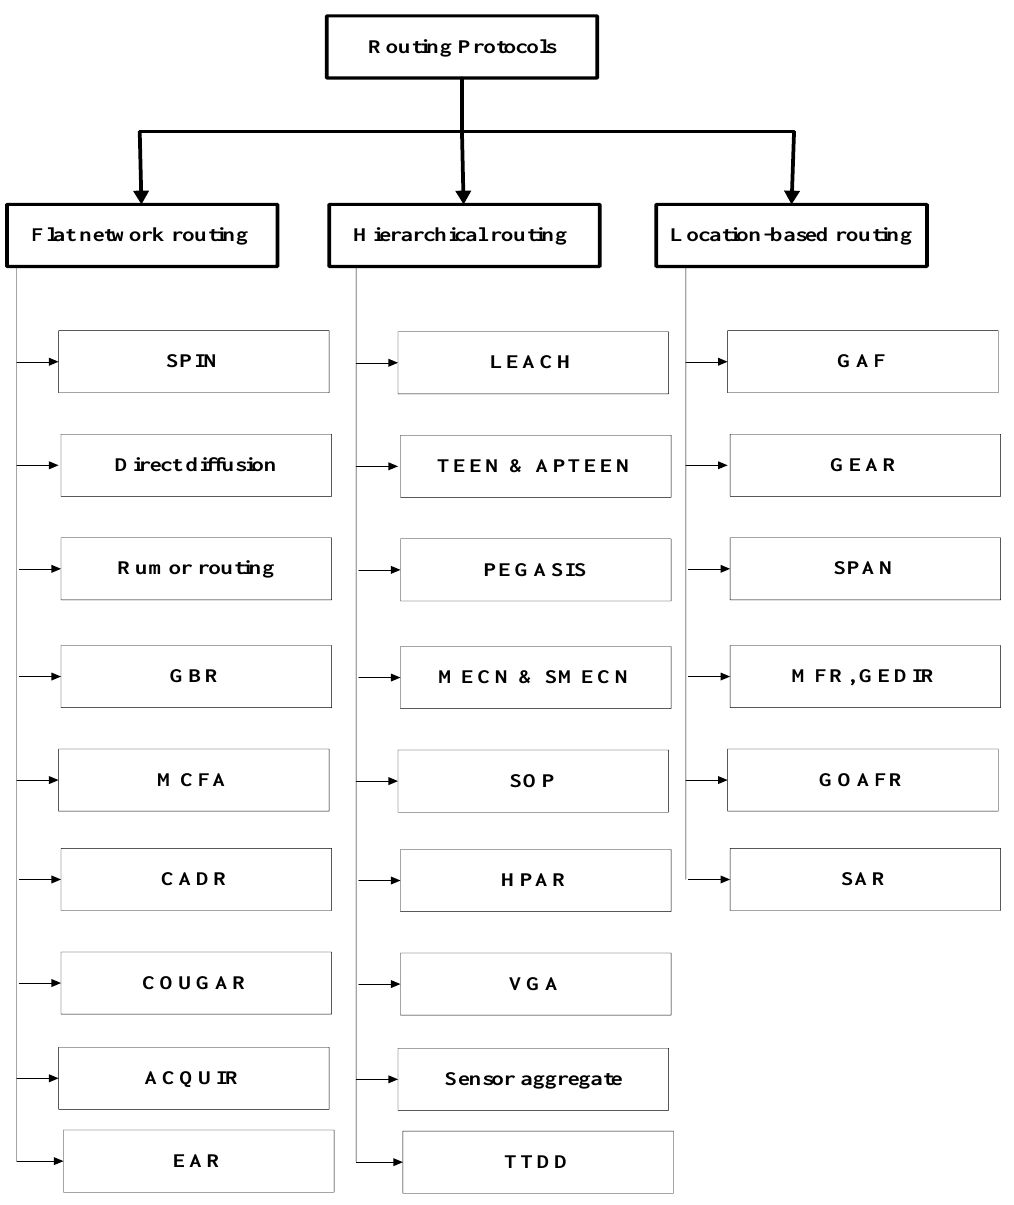
Figure 1. Taxonomy of routing protocols in